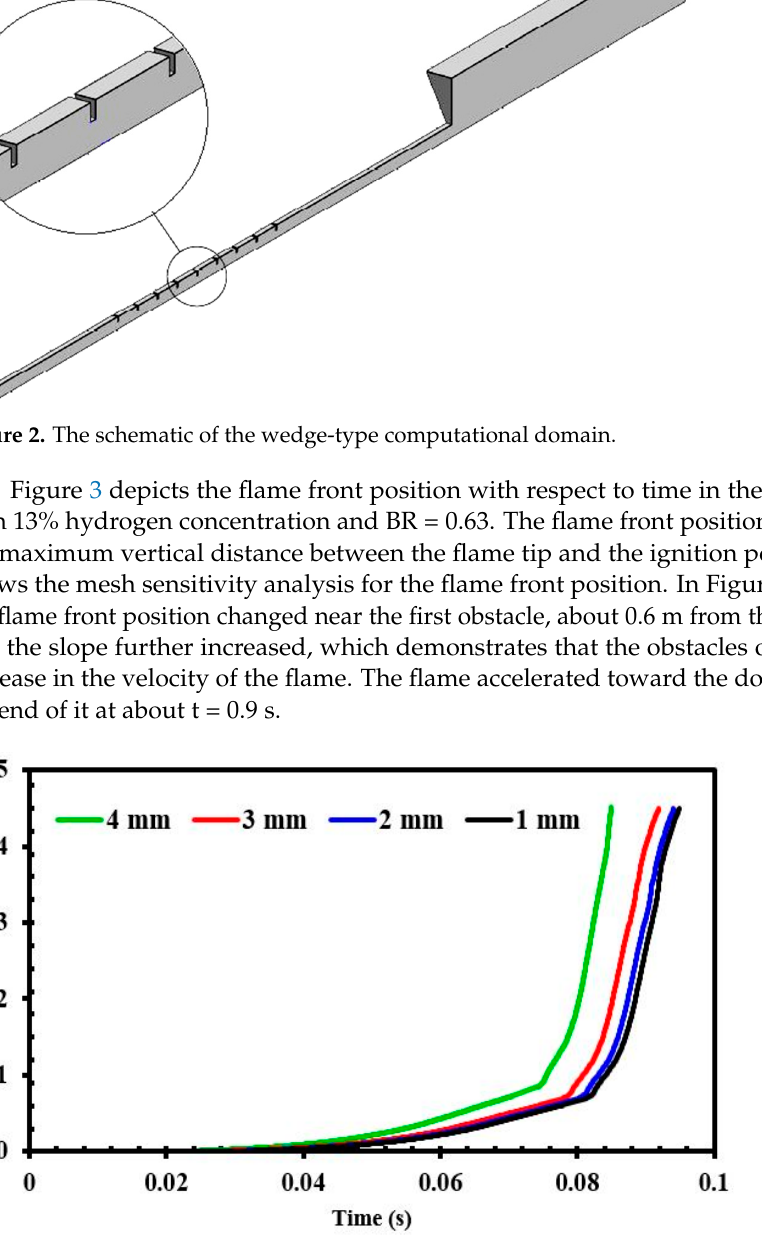
Figure 2. The schematic of the wedge-type computational domain .